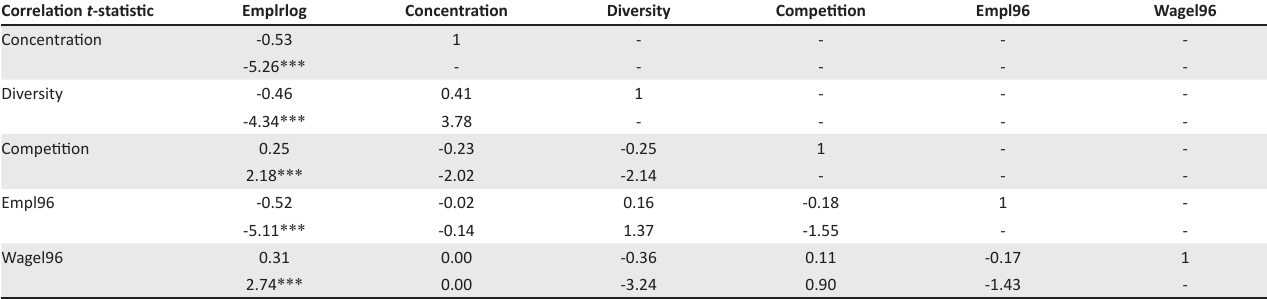
TABLE 11: Correlations of key variables. Correlation t